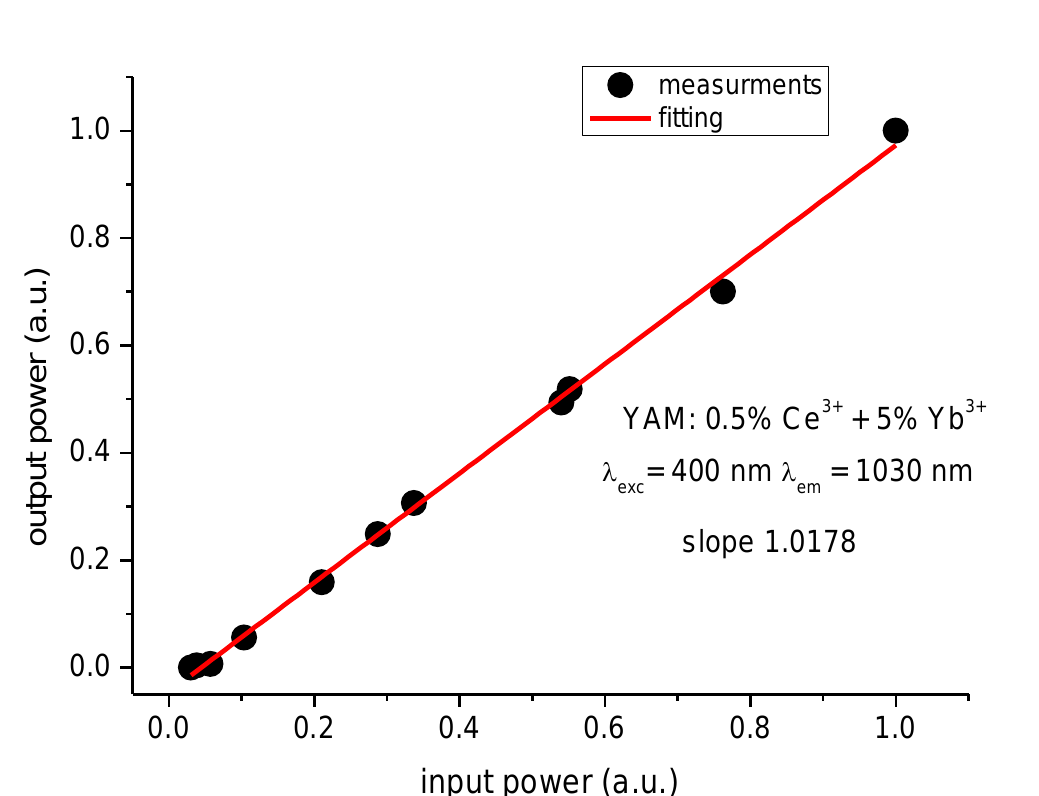
Figure 11. Dependency of Yb 3+ emission intensity monitored at 1030 nm on excitation power at 400 nm (normalized values). The summary of the discussed processes, namely a pathway for obtaining IR emission of Yb 3+ after the Ce 3+ excitation in the UV/blue region, is presented in the energy diagram in Figure 12.